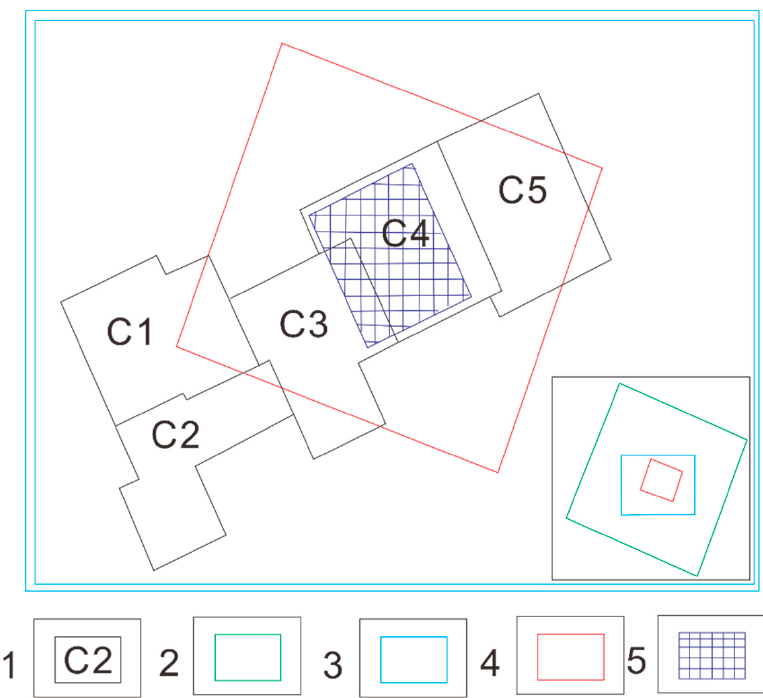
Figure 4. Flow chart of micro-balance calculation for flow rate of pumping and injection unit in mining area. (Note: 1—mining area; 2—boundary of area model; 3-research area; 4—boundary of solute transport model; 5—scope of simulated drilling).